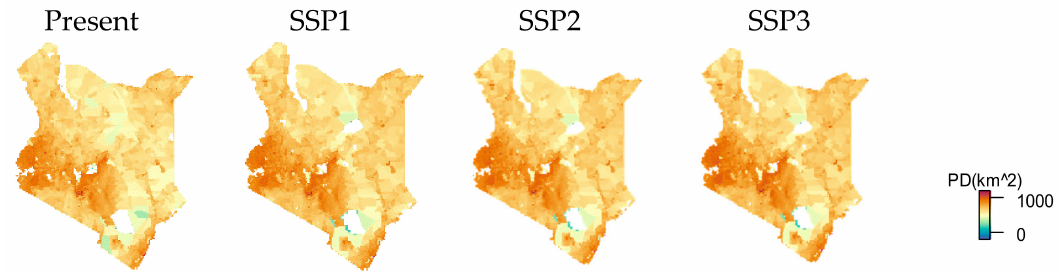
Figure 3. Present and projected future population densities according to 3 shared socioeconomic pathway (SSP)